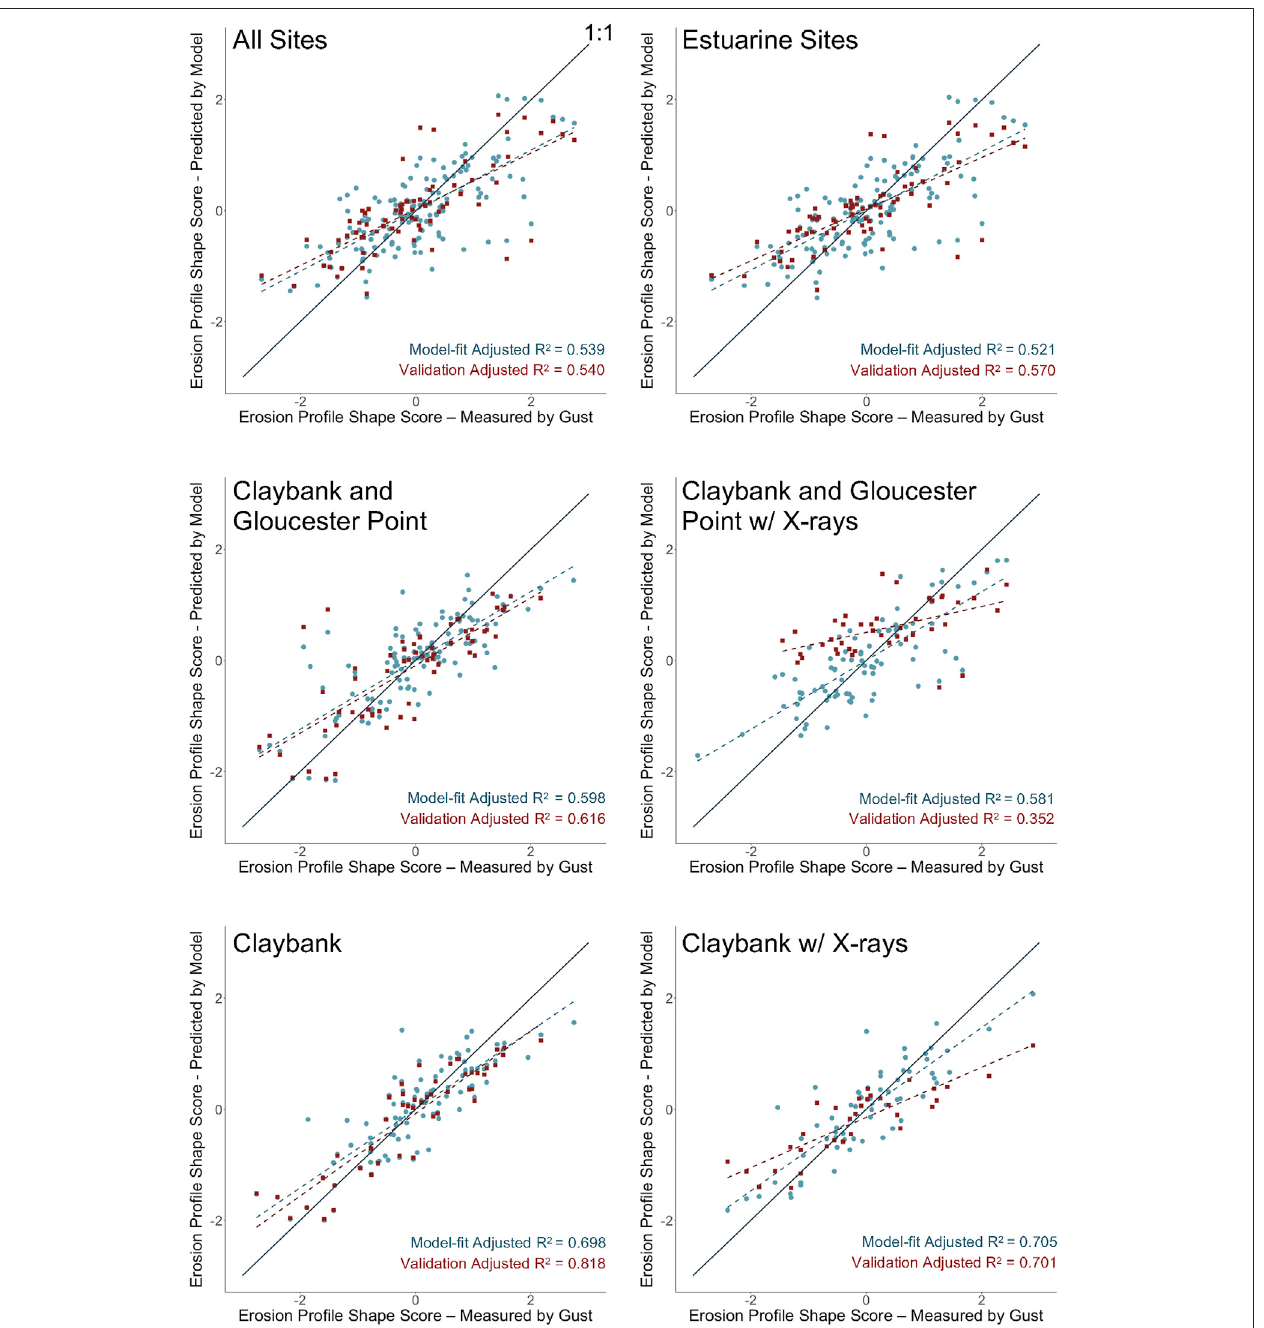
FIGURE A2 | As in Figure A1, but for the Erosion Shape Model Set.